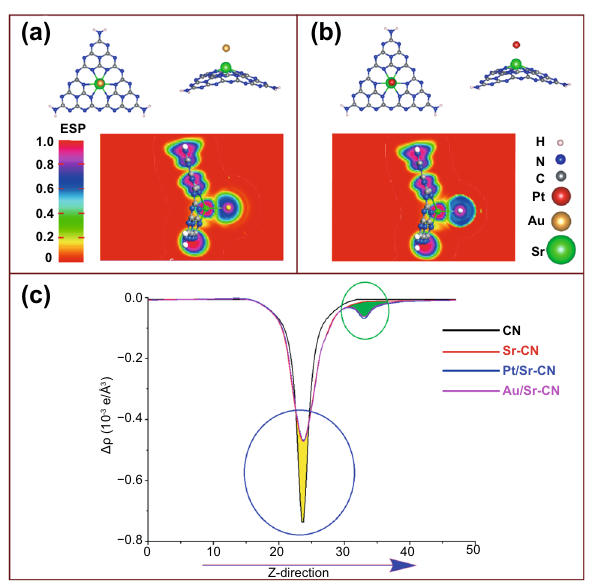
Fig. 7 The optimized geometric structure of Au/0.15Sr-CN along with side view and ESP ( a ), the optimized relaxed structure of Pt/0.15Sr-CN with side view and ESP ( b ), and combined 2D elec- trostatic-potential map of pristine single layer CN, 0.15Sr-CN, Pt/0.15Sr-CN, and Au/0.15Sr-CN catalysts ( c ). In plot (c), the yel- low shaded area denotes donation while green shaded area represents electron